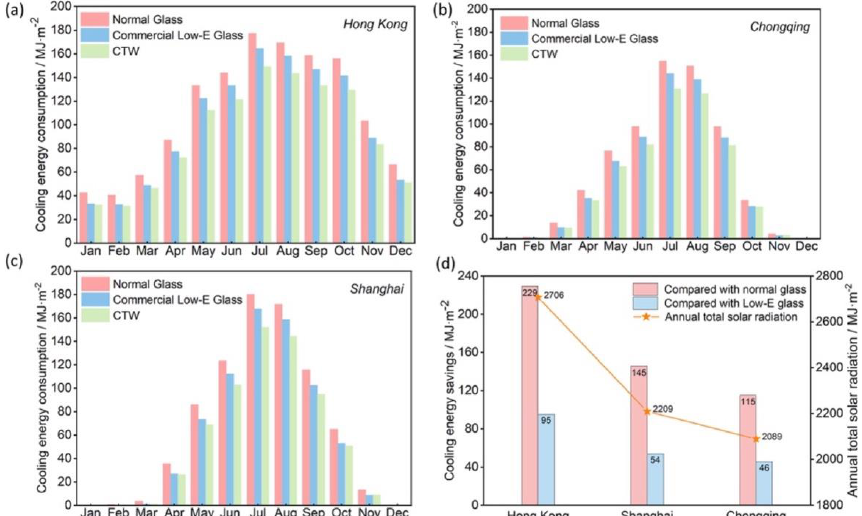
Figure 26. Monthly cooling energy consumption in Hong Kong ( a ), Chongqing ( b ), Shanghai ( c ); annual cooling energy saving compared with the other two types of glazing materials, i.e., standard glass and low-emissivity (Low-E) glass, and annual total solar radiation for the three cities considered ( d ). Reprinted with permission from [42], copyright 2022,